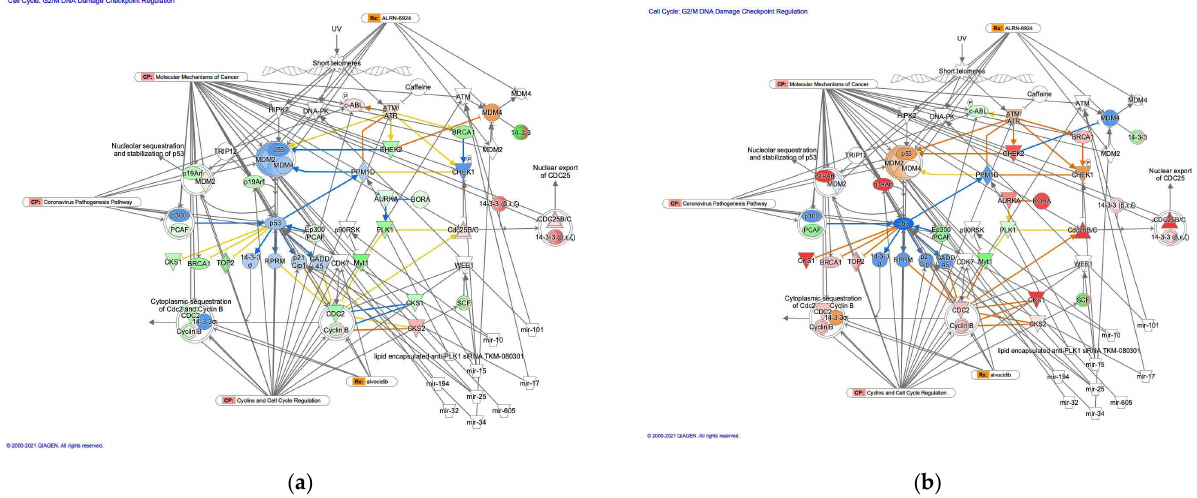
Figure 6 . The G 2 /M DNA damage cell cycle checkpoint regulation pathway in diffuse- and intestinal-type GC. ( a ) Gene expression and pathway activity predictions in diffuse-type GC are shown. ( b ) Gene expression and pathway activity predictions in intestinal-type GC are shown. The genes whose expression was altered in diffuse- and intestinal-type GC are shown in pink (upregulated) or green (downregulated). Predicted activation and inhibition are shown in orange and blue, respectively. Table 6. Non-coding RNAs which have direct relationships in the G 2 /M DNA damage cell cycle checkpoint regulation pathway. Symbol Entrez Gene Name Location Family Lipid-encapsulated anti-PLK1 siRNA